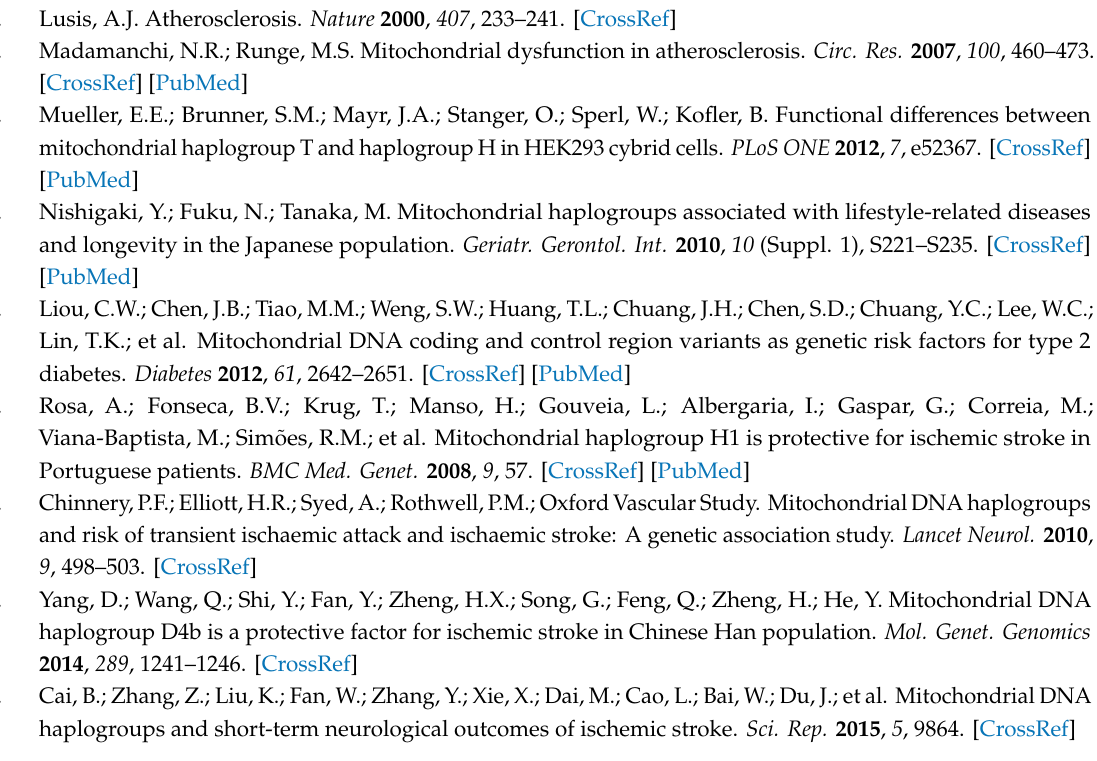
Figure S1: HIF-1 α expressions in di ff erent cybrids under normoxic and hypoxic conditions; Figure S2: Comparisons of intracellular ROS generation (A), induction of MMP-2 (B) in di ff erent cybrids under hypoxia-ischemia. Table S1: 24 pair primers for the mitochondrial DNA to perform the gene amplification by polymerase chain reaction; Table S2: The oligonucleotide probes sequences for mtDNA haplogrouping; Table S3: Summary of the major non-synonymous mtDNA variants in the coding region of various mitochondrial